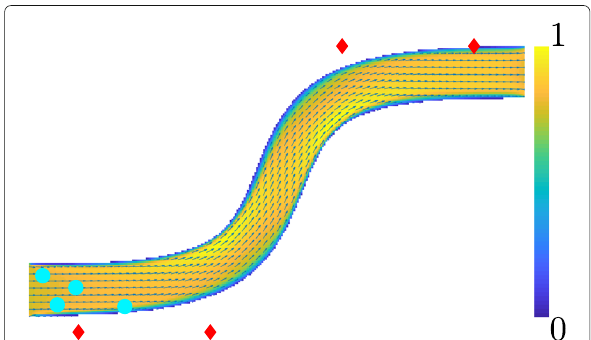
Fig. 3 Four agents (turquoise) in a pipeline. This setup was used for CFD simulations with dimensions of 11.2 m × 6.48 m and four beacons (red diamonds). The different colors (blue to yellow) indicate different speeds, and the arrows indicate the direction of the flow. The figure shows the velocity normalized to the max. occurring velocity